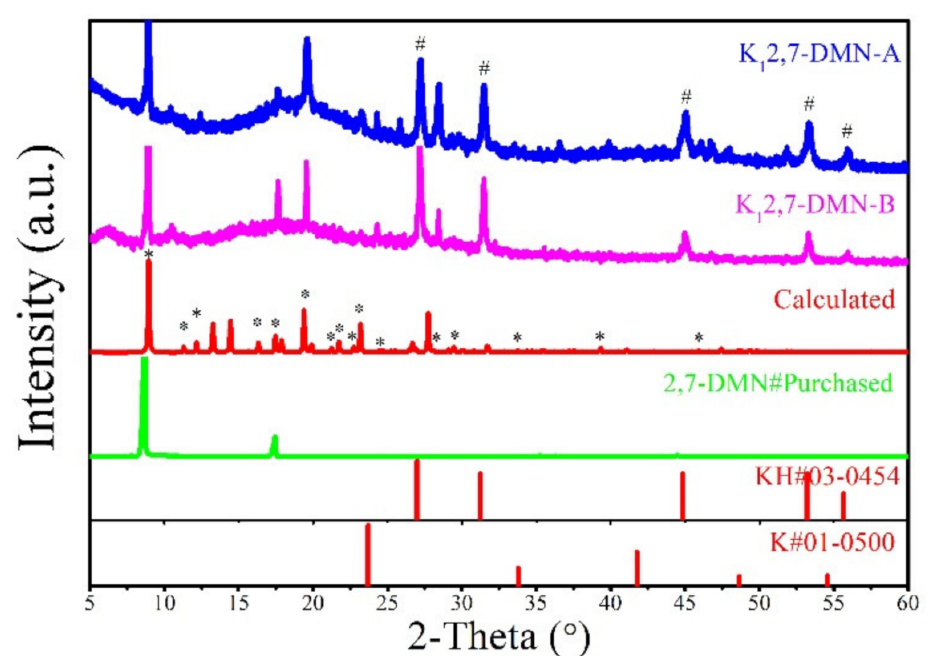
Figure 2. XRD pattern of pristine and potassium-intercalated 2,7-DMN. The symbol “#” represents the peak position of KH. “Calculated” refers to the XRD profile of the theoretical structure. The symbol “*” indicates the calculated position that coincides with the experimental